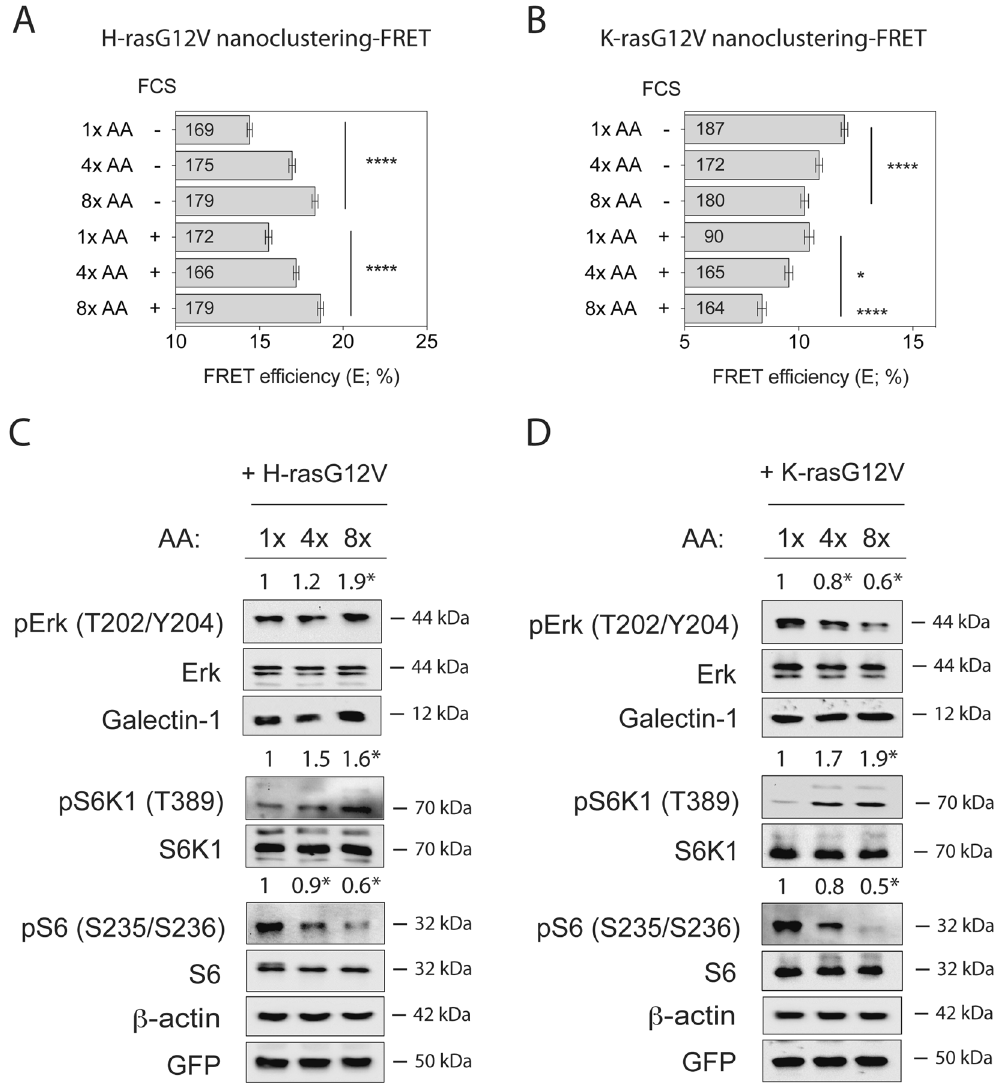
Figure 2. Amino acid increase oppositely affects H-ras and K-ras activity. ( A , B ) Nanoclustering-FRET analysis in HEK cells co-expressing mGFP- and mCherry-tagged ( A ) H-rasG12V or ( B ) K-rasG12V. Cells were incubated for 24 h with increasing concentrations of amino acids (1x, 4x or 8x) in the absence or presence of serum (FCS) as indicated. The numbers in the bars indicate the number of analyzed cells (mean ± SEM, n = 3). ( C , D ) Western blot analysis of Ras- and mTORC1-signalling in HEK cells expressing mGFP-H-rasG12V or mGFP-K-rasG12V. Cells were treated as in ( A , B ) under serum-starved conditions. Numbers indicate the ratio of phosphorylated to respective total protein levels (n = 4). Statistical significance levels are annotated as * p < 0.05; **** p <